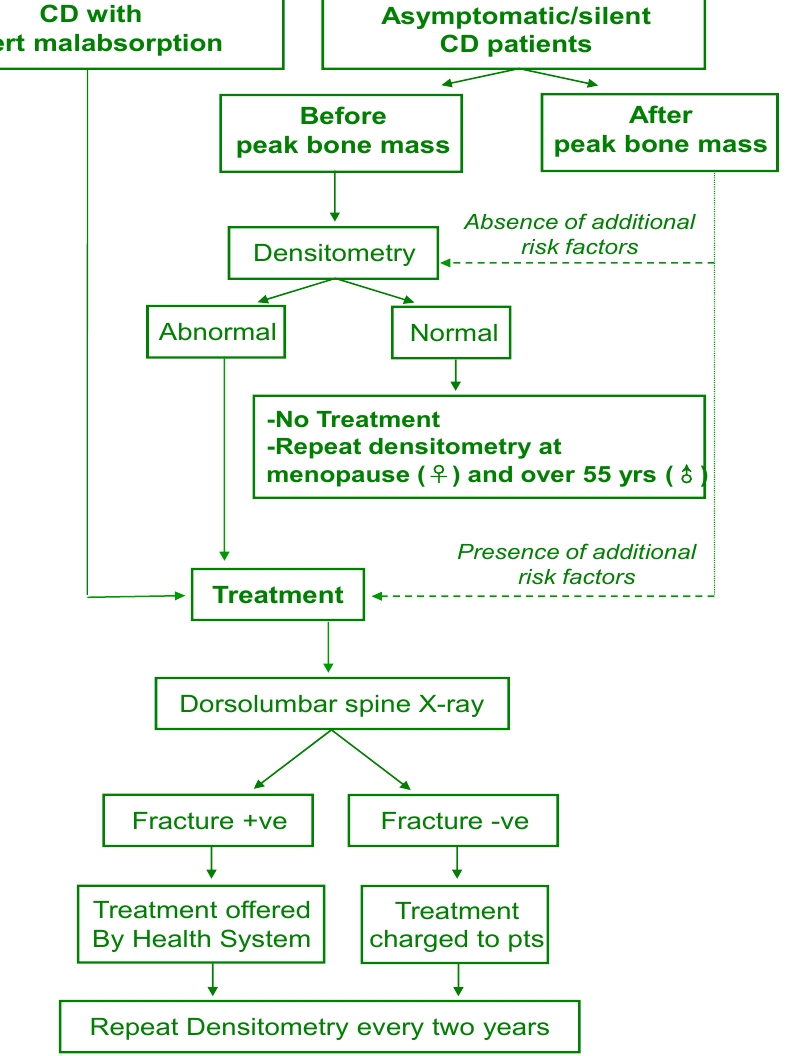
Figure 1. Diagnostic and therapeutic approach to CD patients without a previous